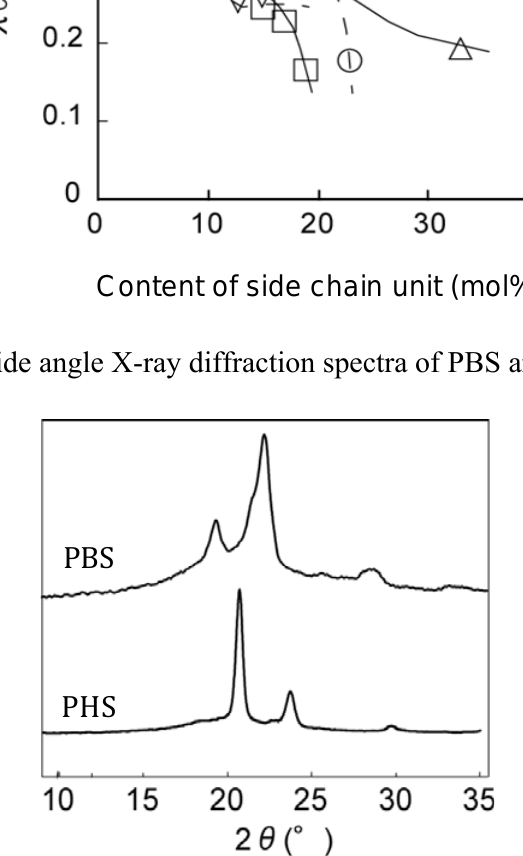
) of PBS/M-6 ( △ ), PHS/M-6 ( □ ), PBS/M-16 ( ○ ) c